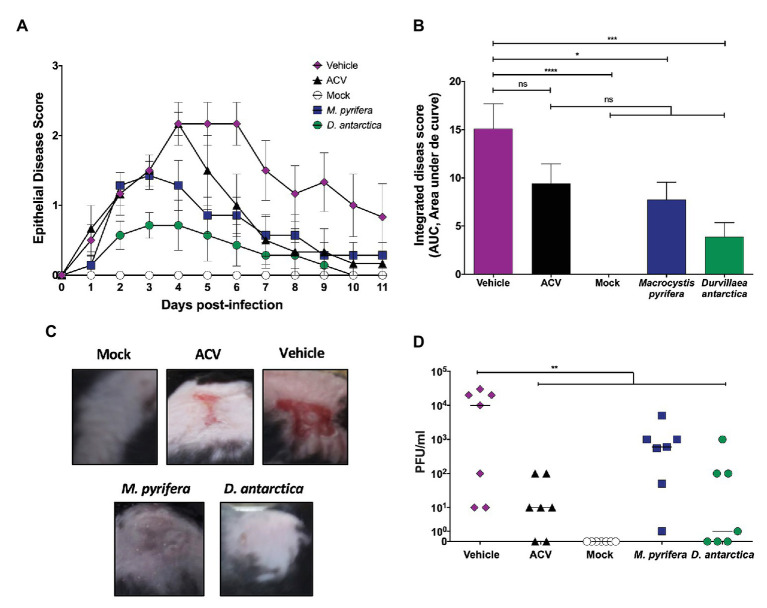
Therapeutic effect of the M. pyrifera and D. antarctica algae extracts in an HSV-1 skin infection model. Mice were infected with HSV-1 in the flank skin and treated 24 h after infection with the algae extracts formulated in a hydrogel preparation at 5 mg/ml twice a day. The vehicle, commercially available 5% acyclovir cream, and mock-infected animals were included as controls. (A) Skin clinical scores were assessed daily for each animal. (B) Area under the curve (AUC) values, which integrates the clinical skin scores and their duration between day 0 and day 11 post-HSV-1 infection. (C) Representative images of skin lesions at day 5 post-infection with HSV-1. (D) Viral titers (PFU/ml) in 200 mg of skin biopsies obtained at day 5 post-infection. Data shown are means ± SEM of two independent experiments (n = 7/group). The data were analyzed using one-way ANOVA with Bonferroni’s post-test. ****p < 0.0001; ***p < 0.001; **p < 0.01; and *p < 0.05.